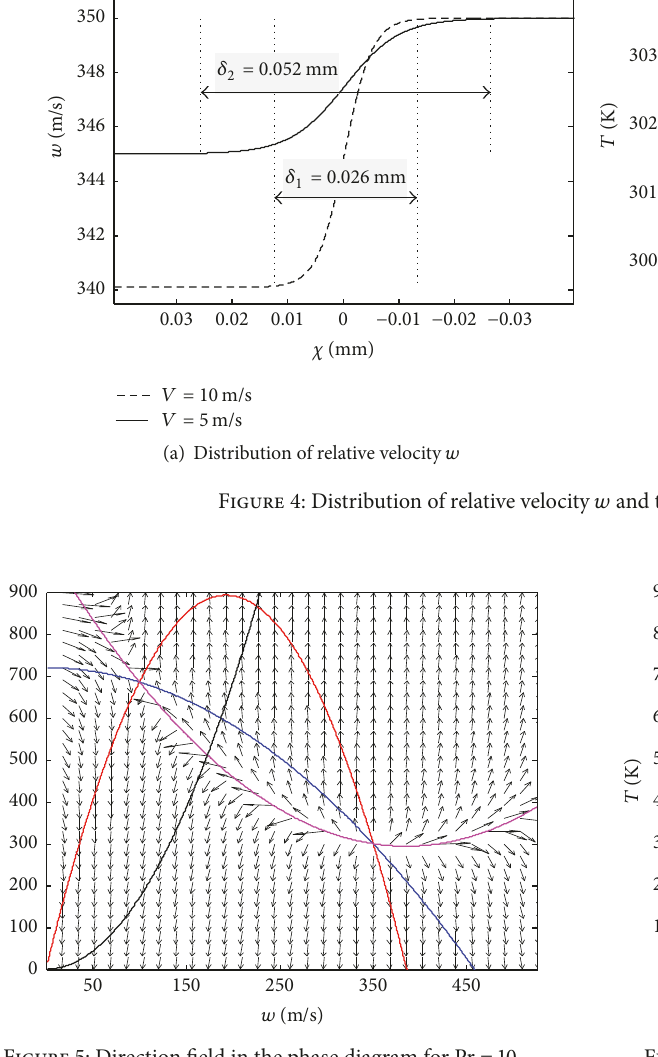
Figure 5: Direction field in the phase diagram for Pr = 10.